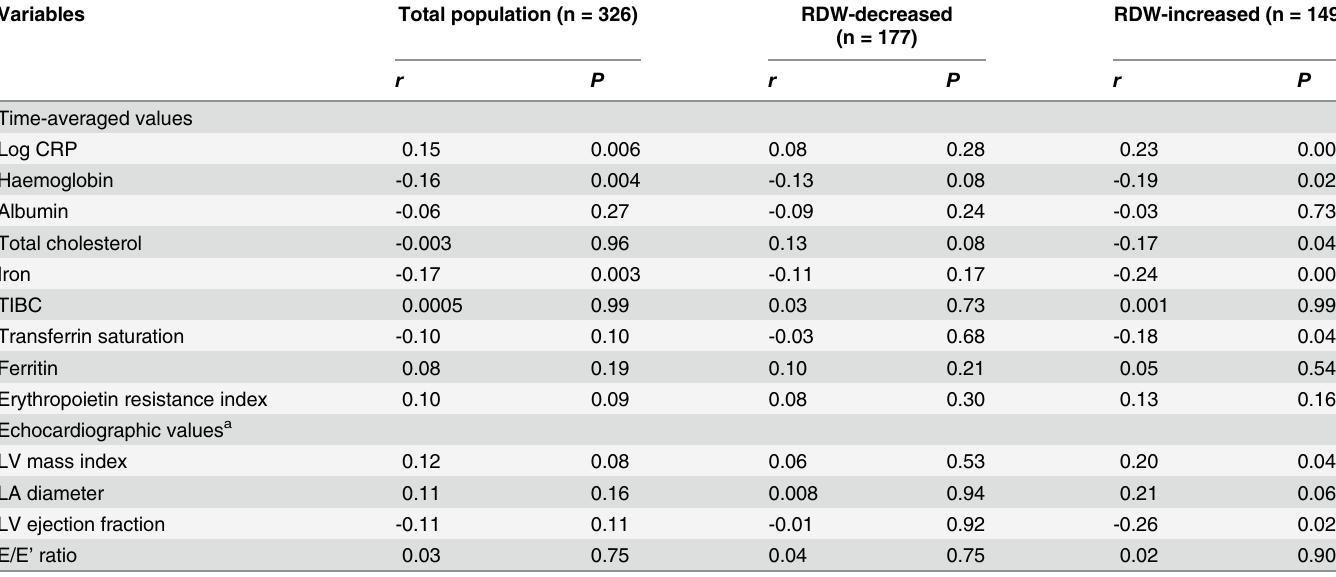
Table 3. Correlations between time-averaged RDW value and other parameters.